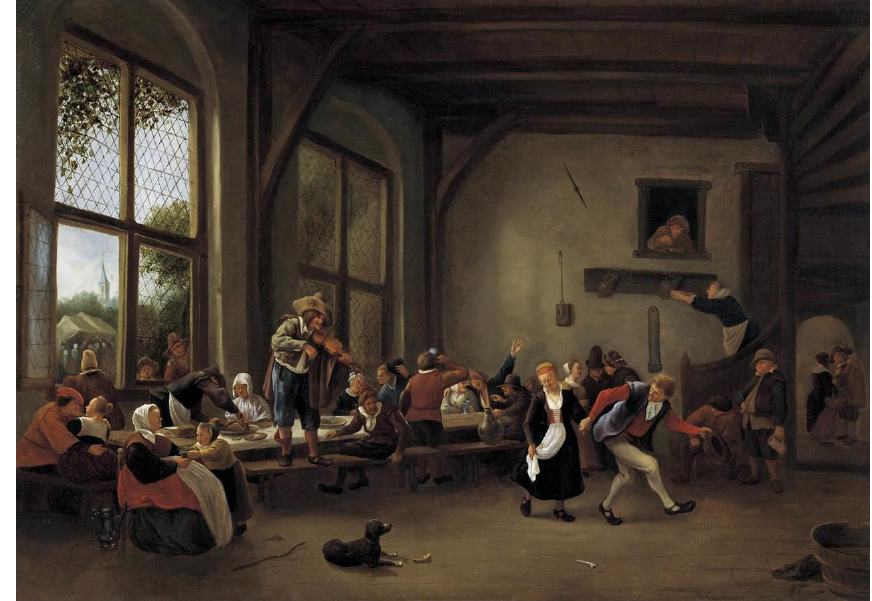
Figure 12. Jan Steen, Country Wedding, 1666, Private Collection.